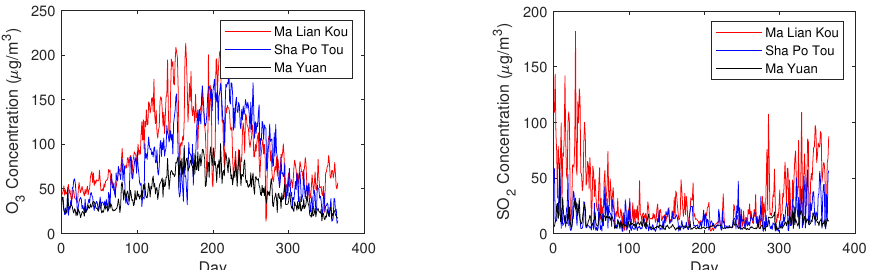
Figure 4. The variations of the concentrations for O 3 and SO 2 at Ma Lian Kou, Sha Po Tou and Ma Yuan in